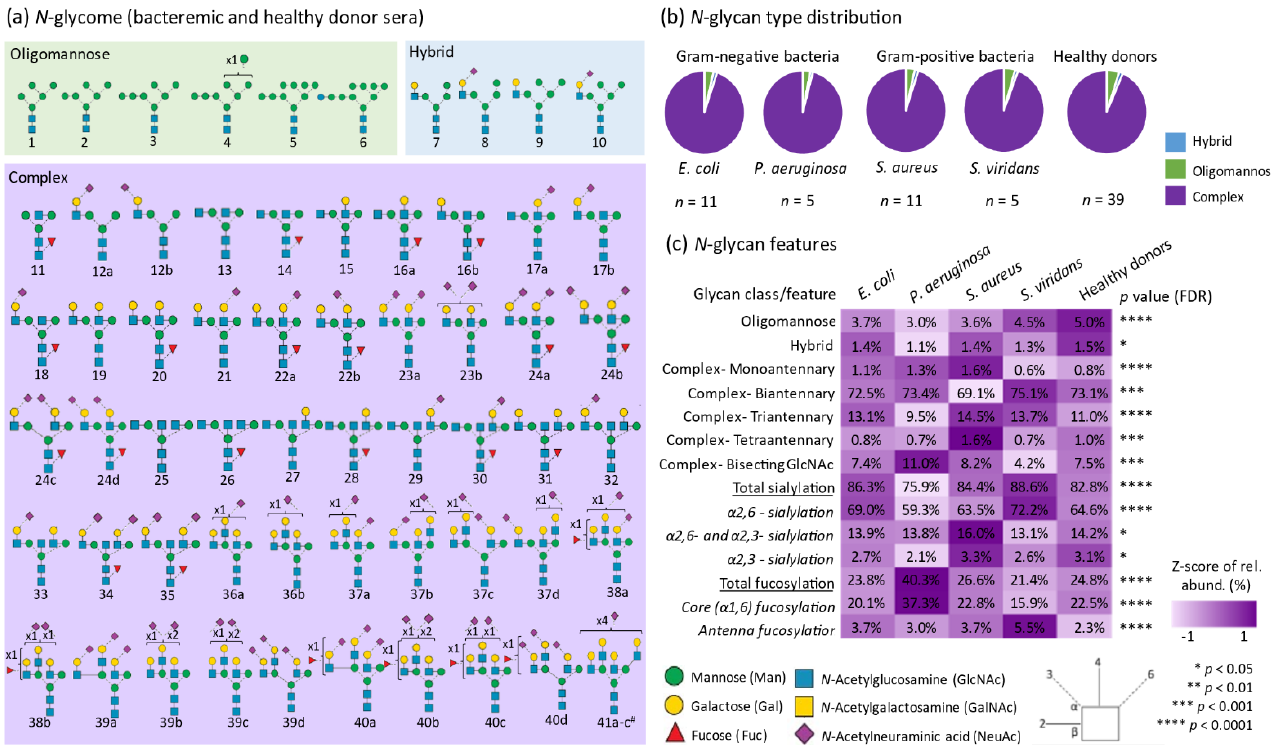
Figure 2. Overview of the N -glycome profile of bacteremic and healthy donor sera. ( a ) Map of the identified N -glycan isomers and the glycan identifiers used in this study (glycan 1-41c). # a single glycan isomer has been depicted since the exact glycan fine structures could not be determined for these three isomeric structures. Distribution of the ( b ) N -glycan types, i.e., complex-, hybrid-, and oligomannosidic-type, and ( c ) structural features of the complex-type N -glycans including the antennary patterns, bisecting GlcNAcylation, and the positions and linkages of terminal sialic acid and fucose residues. The mean relative abundances of various glycan features are indicated for all patient groups and the healthy donors and complemented with a heat-map representation after Z- score transformation of the relative glycan abundances. Statistical significance was tested using ANOVA followed by FDR correction ( p < 0.05). See key for the used symbol and linkage nomenclature [62].